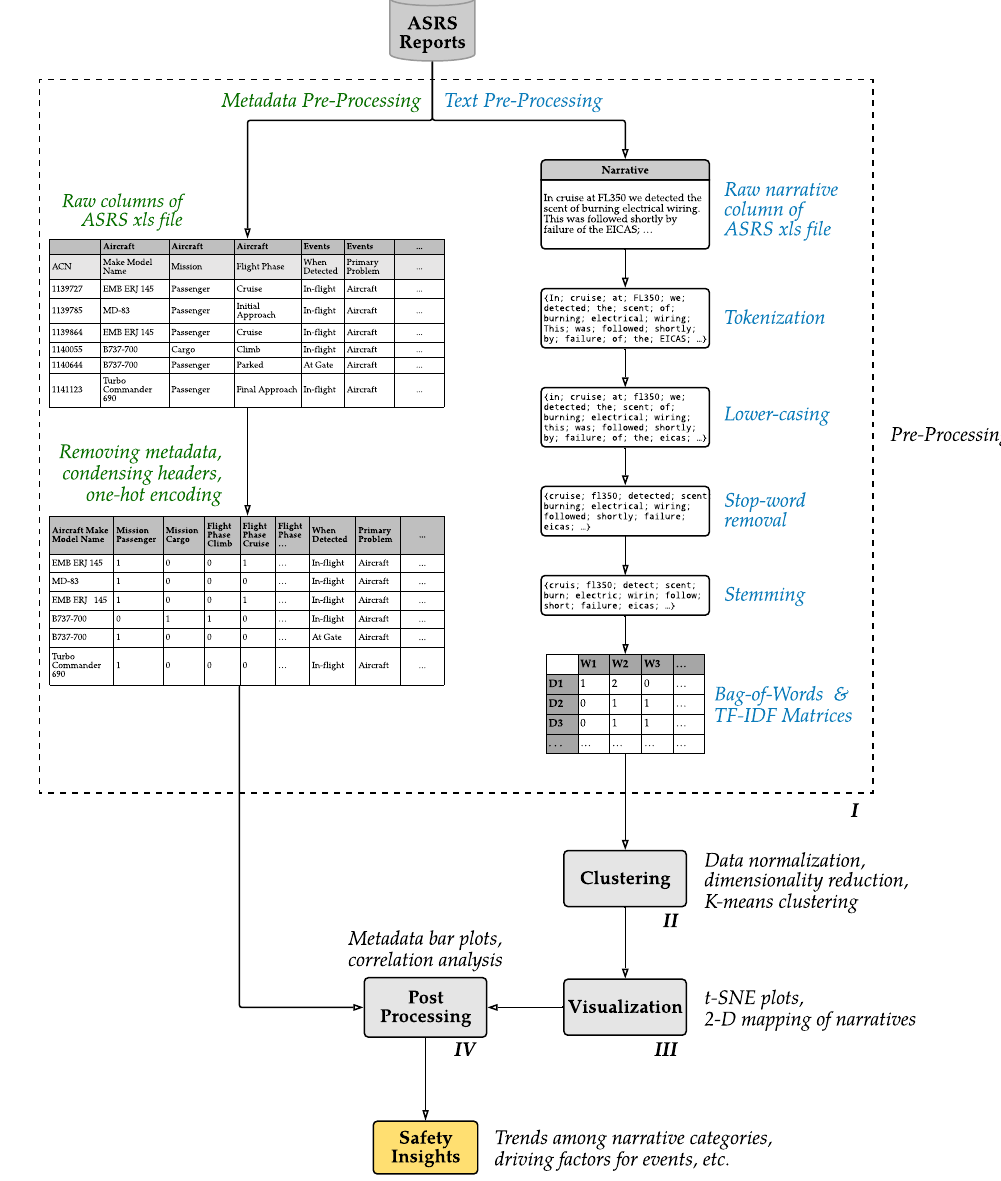
Figure 1. Methodology for classification and visualization of safety